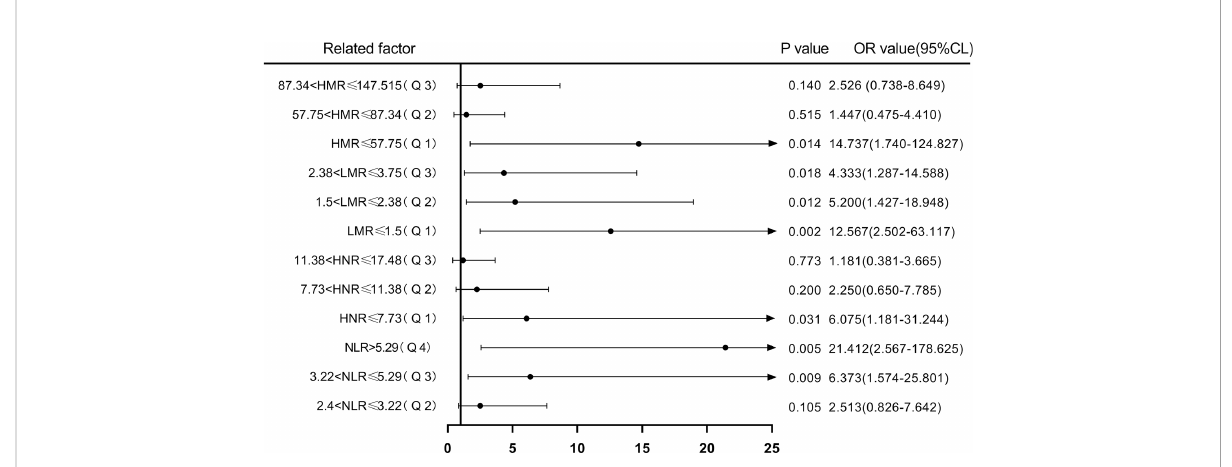
FIGURE 7 Forest plot of one-way logistic regression analysis of NLR, LMR, HNR, and HMR (four groups of classi fi cation) in predicting NSCLC